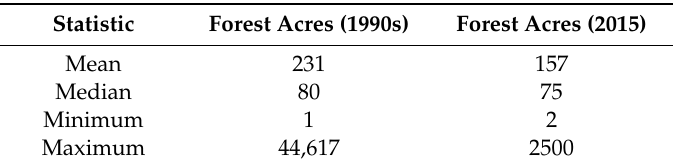
Table 2. Comparison of the sample estimates obtained from mail surveys conducted in the 1990s and